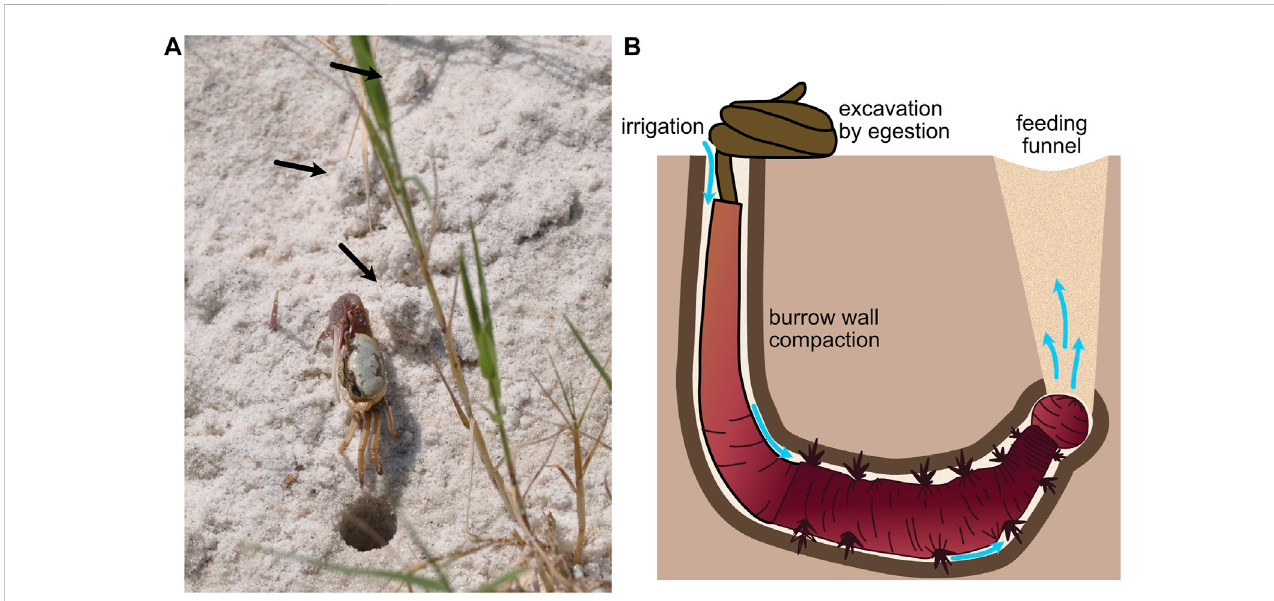
FIGURE 5 (A) Fiddler crab showing excavated material (black arrows) around the burrow (burrow opening ~1 cm diam). (B) Schematic of arenicolid polychaete, showingburrowwallcompactionandexcavationbyingestionofsedimentsattheanterioroftheburrowandegestionatthesedimentsurfaceincharacteristic fecal mounds. The worm uses peristalsis to pump water from the tail shaft anteriorly through the burrow (blue arrows). Feeding causes collapse of overlying sediment to form a feeding funnel. Worm drawing by Erin